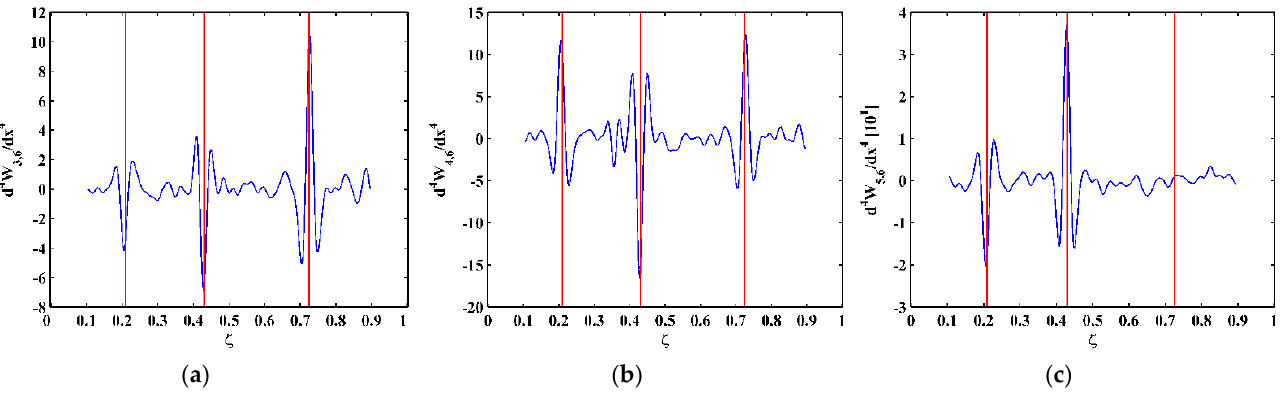
Figure 16. Derivatives of the ( a ) third, ( b ) fourth, and ( c ) fifth multi-scale mode shapes (locations of cracks are indicated by red lines).